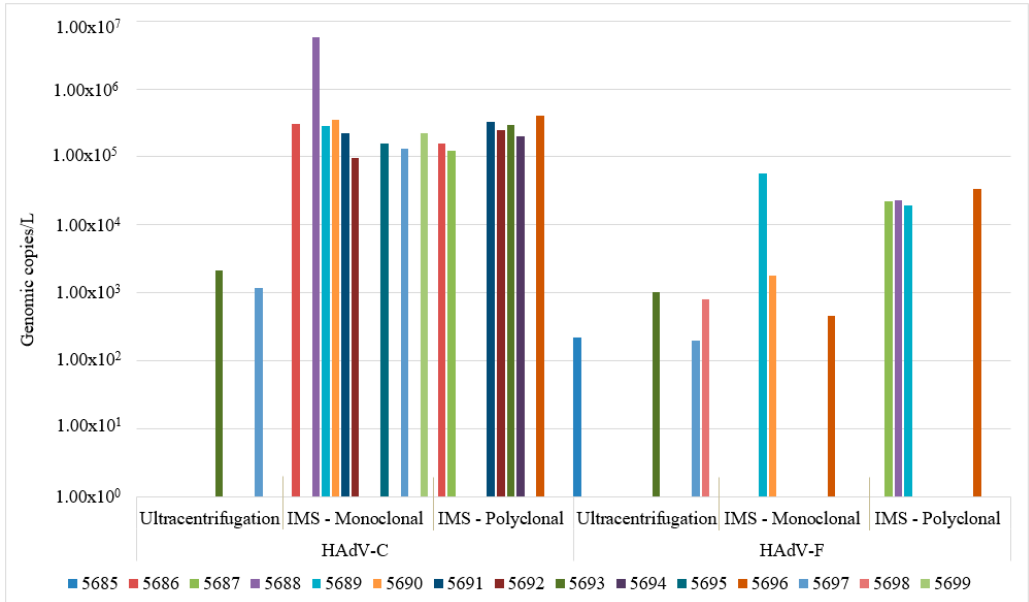
Figure 7. Results of HAdV-C and -F in water samples comparing ultracentrifugation and IMS methods detected by qPCR.